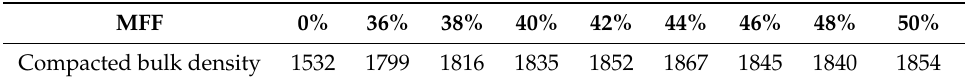
Table 6. The compacted bulk density of the mixed aggregate (kg / m 3